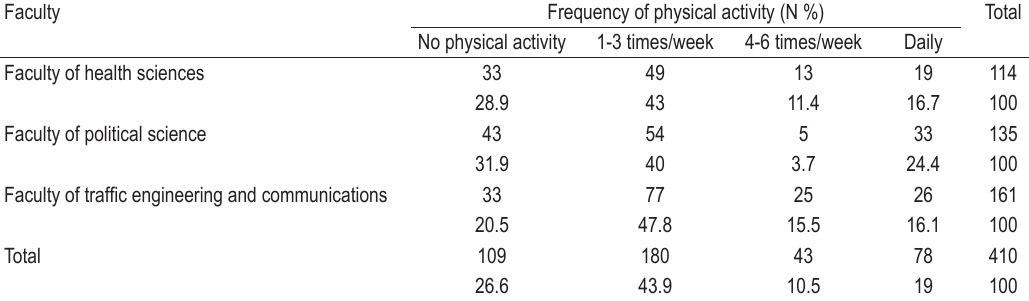
TABLE 5. The frequency of physical activity in three groups